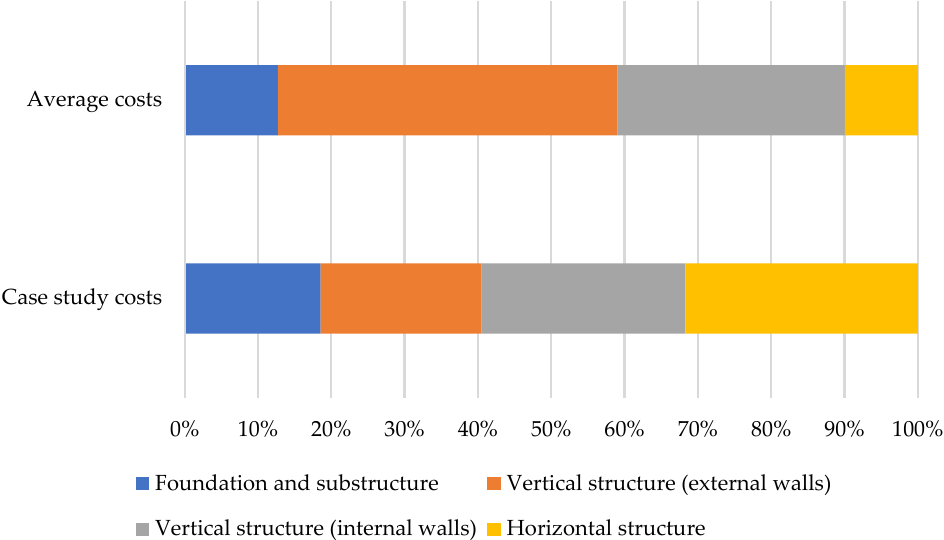
Figure 7. A comparison of case study specific costs and average investment costs presented within different structures.